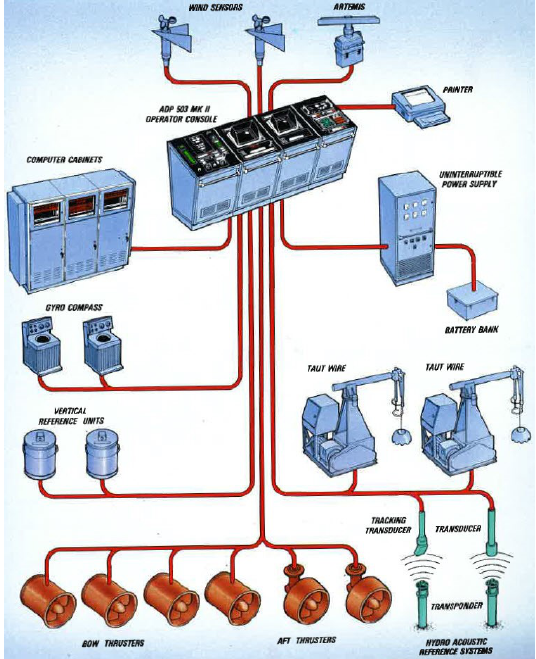
Figure 7: The ADP configuration for the diving sup- port vessel Wilchief. Illustration: